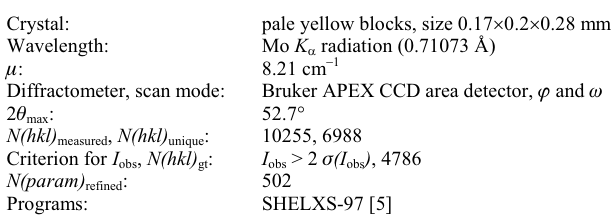
Table 2. Atomic coordinates and displacement parameters (in Å 2 )